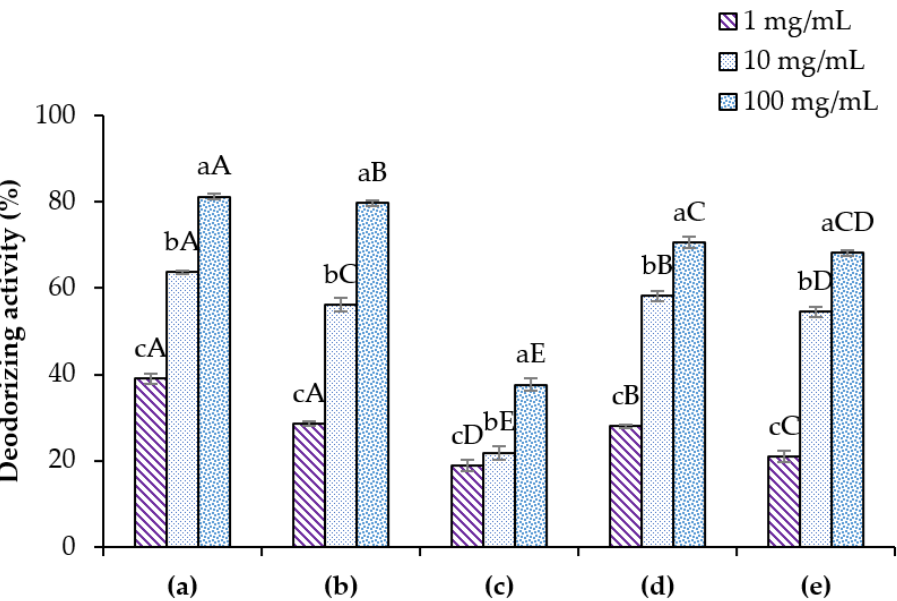
Figure 8. Deodorizing activity of ( a ) ME, ( b ) EGCG, ( c ) prototype cream, ( d ) developed deodorant cream mixed with ME and 1.0% ( w / v ) H-CMCH (H2), and ( e ) prototype cream mixed with EGCG and 1.0% ( w / v ) H-CMCH at different concentrations (1, 10, and 100 mg/mL). Different lowercase letters (a,b,c...) indicate significant differences between concentrations in the same formula, and different uppercase letters (A,B,C...) indicate significant differences between formulas at the same concentration. Table 2. Antioxidant properties of the developed deodorant cream compared to prototype formula.